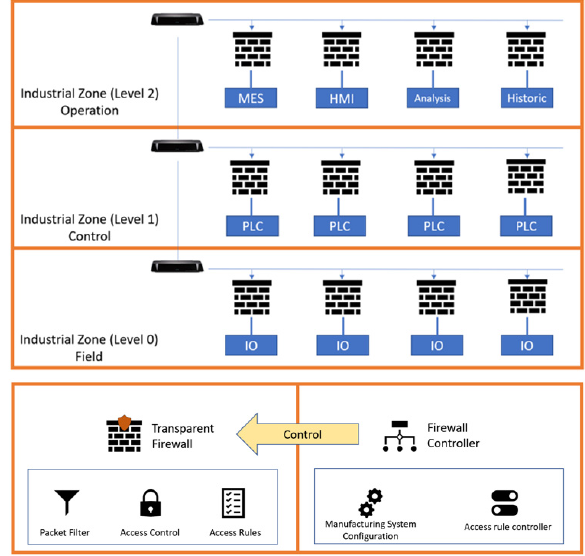
Figure 5. SDN Firewall for Smart